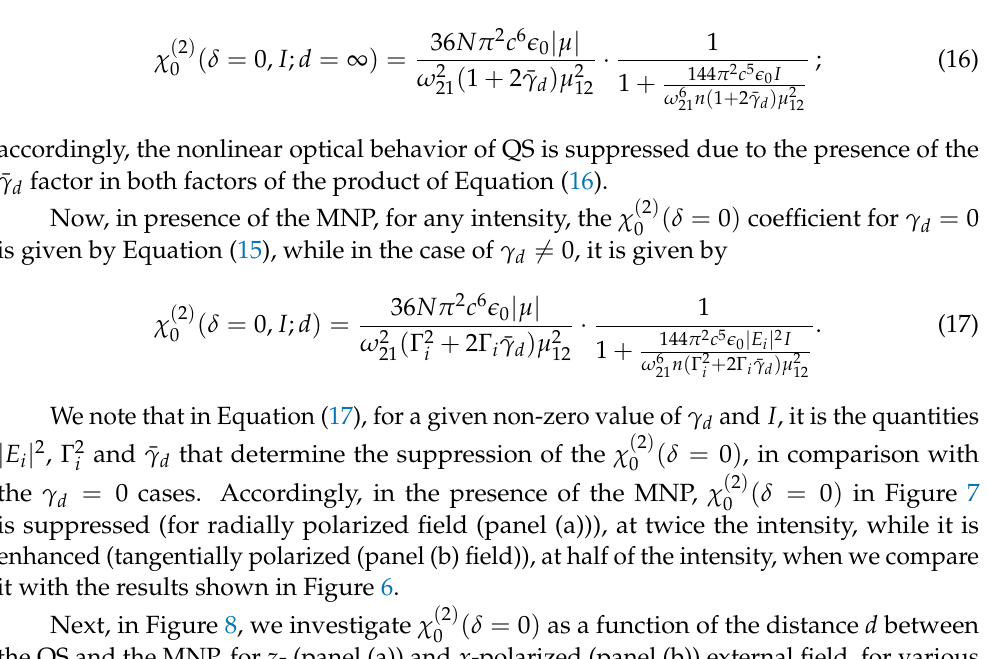
( 2 ) ( δ = 0 ) as a function of the intensity I in presence of the MNP for various γ Figure 7. χ 0 µ 12 is along the z -axis and d = 50 nm. ( b ) The µ 12 is along the x -axis and d = 34.5